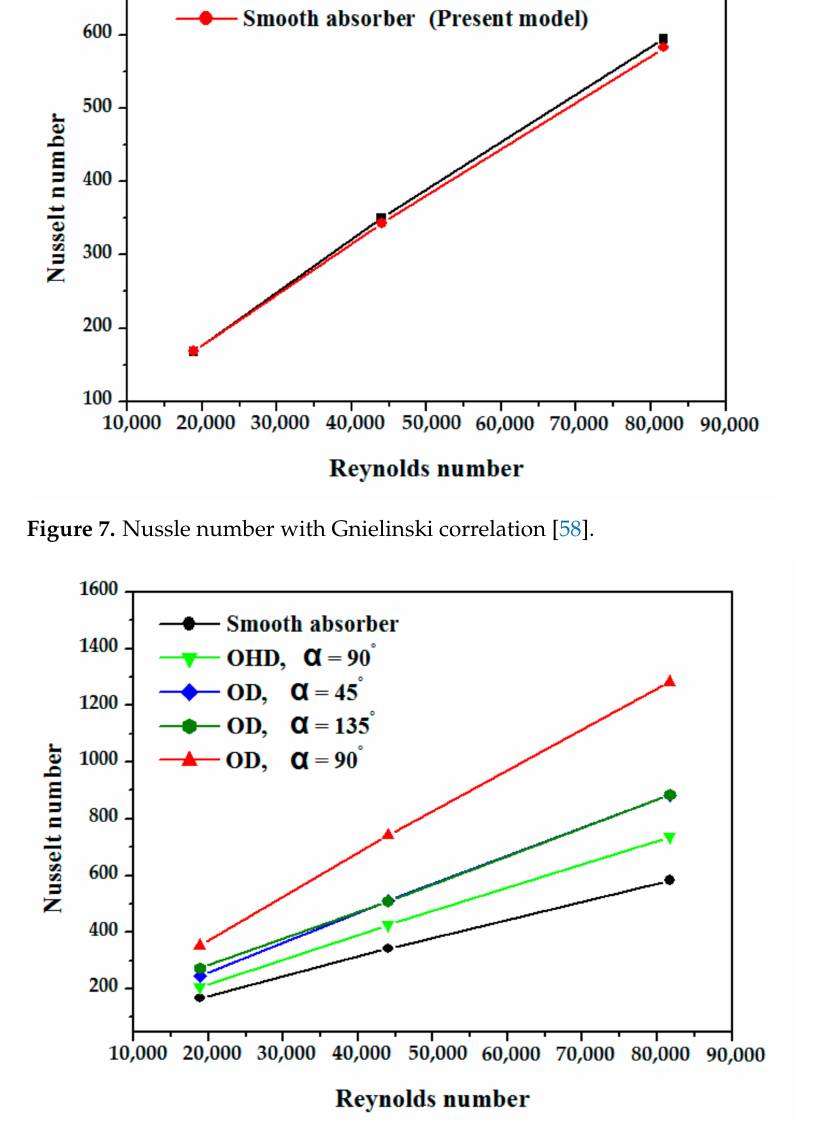
Figure 8. Nu variation in the absorber vs. Reynolds number (P/D =